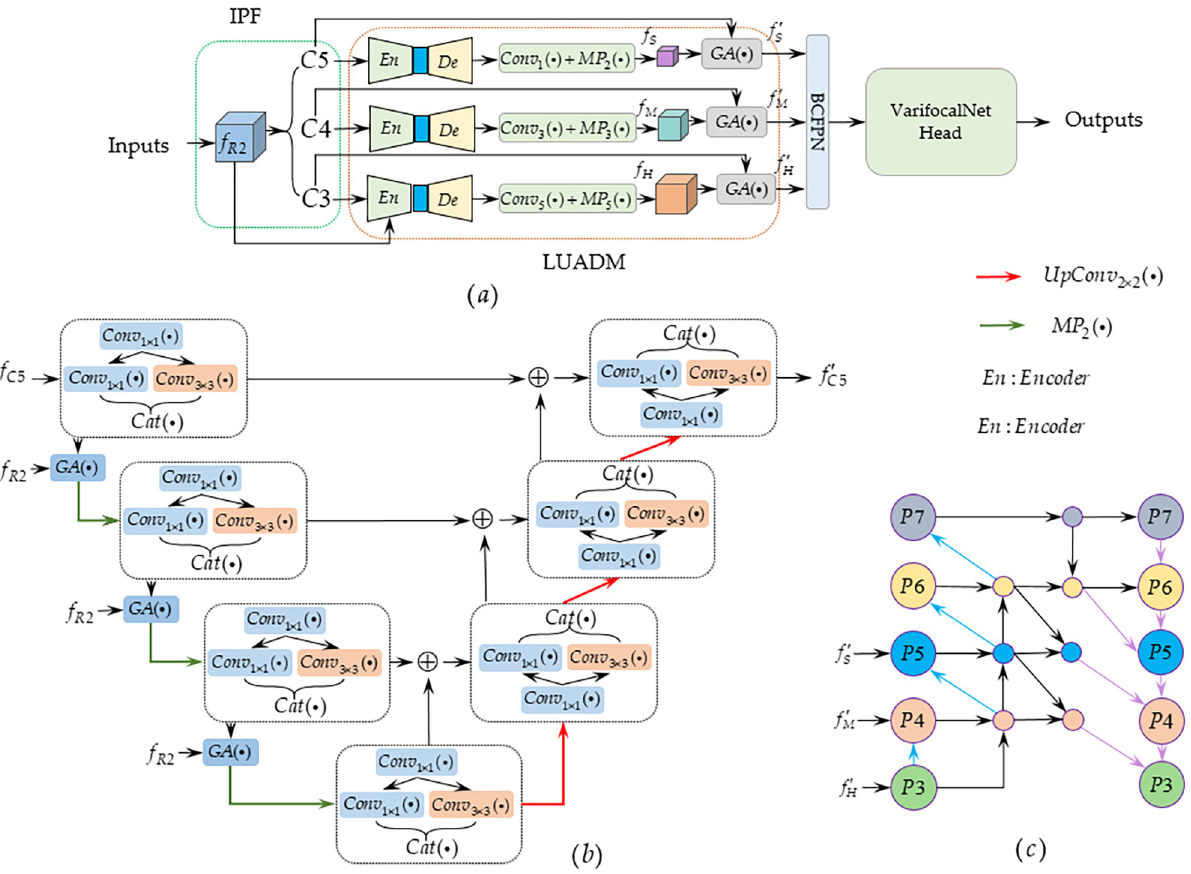
Fig 1. (a) The overall structure of the LUANets detection framework. (b) Represents the LUADM of C 5. (c) The bidirectional cross-aggregation FPN (BCFPN) module. f represents the features extracted by Res2Net-101 [35]. C 3, C 4, C 5 respectively represent the convolution operation of different R 2 hole coefficients, and the output feature can be defined as f C 3 , f C 4 , f C 5 . EN , De represents the encoder and decoder, respectively. GA ( ��� ) represents the global attention operation. f , f , f represent different levels of feature information, such as low, middle, and high. BCFPN represents the bidirectional s M H cross-aggregation FPN module. Conv 1 × 1 means that the convolution kernel is 1 × 1, RELU + BN and other operations. represents the feature map connection. MP 2,3,5 ( � ) represents the maximum pooling operation of separate scales. � means skip connection. { P 5 , ��� , P 7 } represents a pyramid structure of different